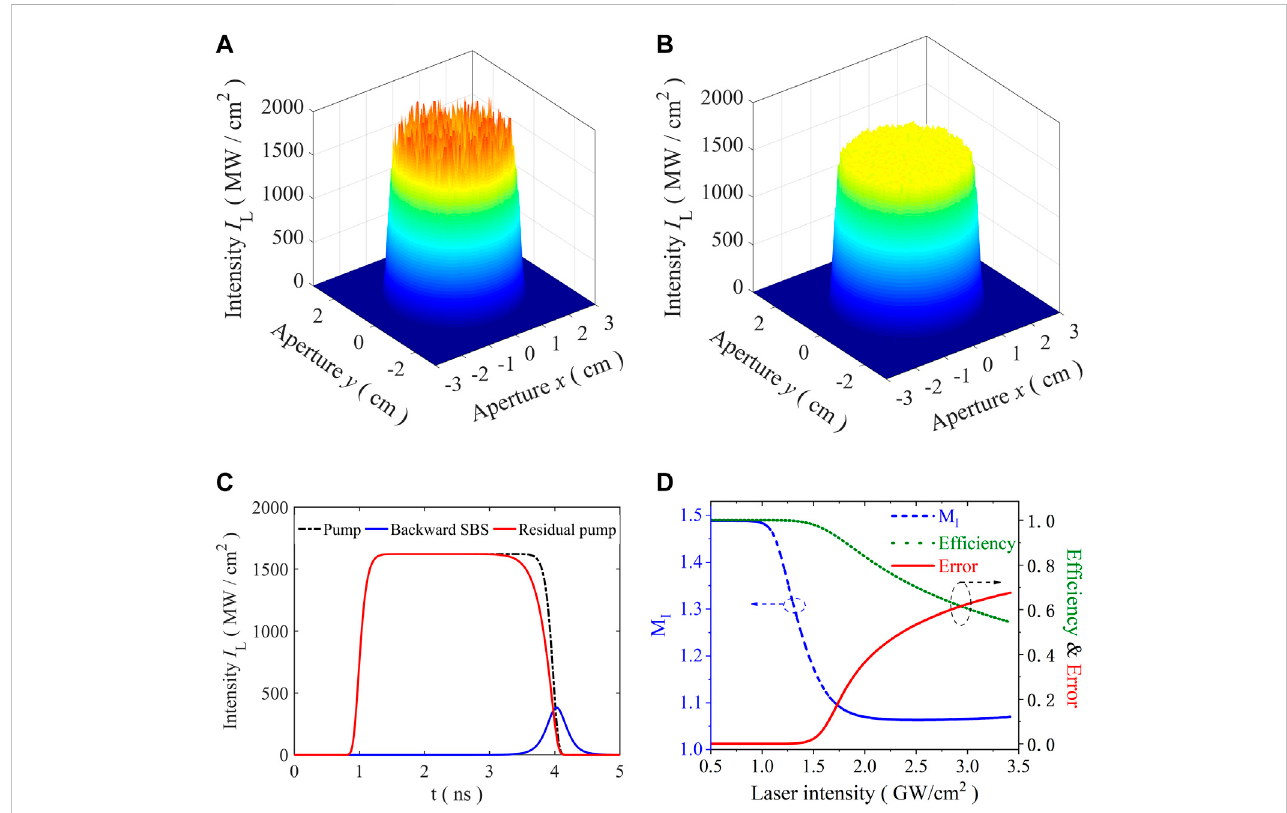
FIGURE 1 NumericalresultsofSBSbeamsmoothing. (A) Near fi eldpatternofthepump (B) Near fi eldpatternoftheoutputlight (C) Typicalwaveformsofthepump, Stokes and output pulse (residual pump) (D) Evolution of MI, η and PDR with the increasing of laser intensity.